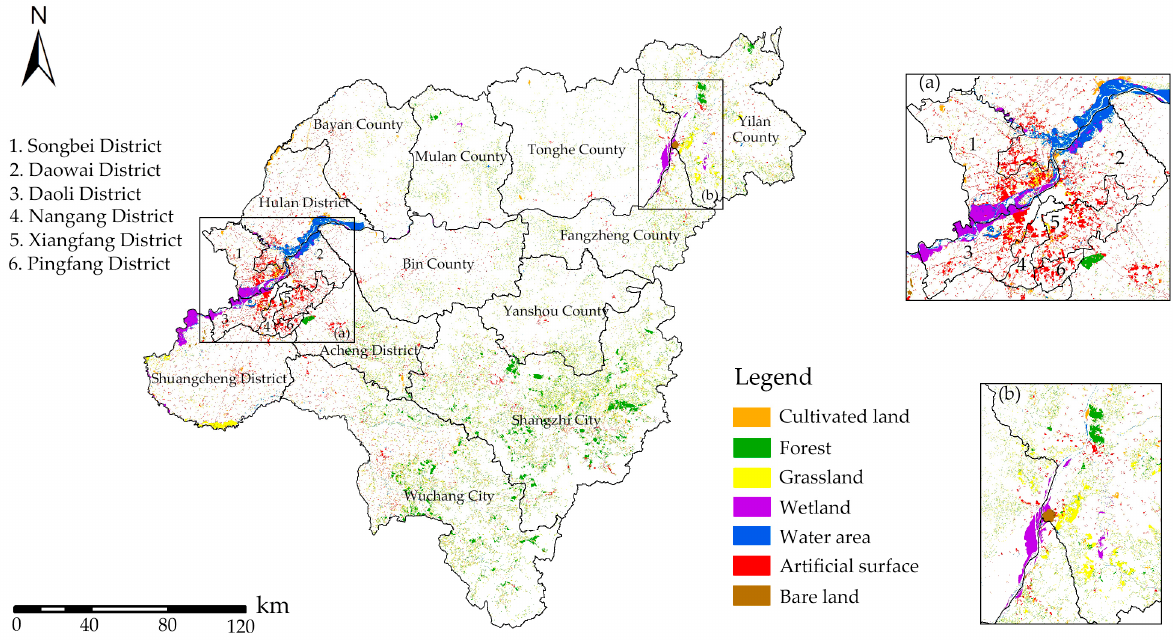
Figure 3. Land cover gain from 2020 to 2010. ( a ) Land cover gain in urban Harbin from 2020 to 2010. ( b ) Land cover gain at the junction of Tonghe, Yilan and Fangzheng counties from 2020 to 2010.